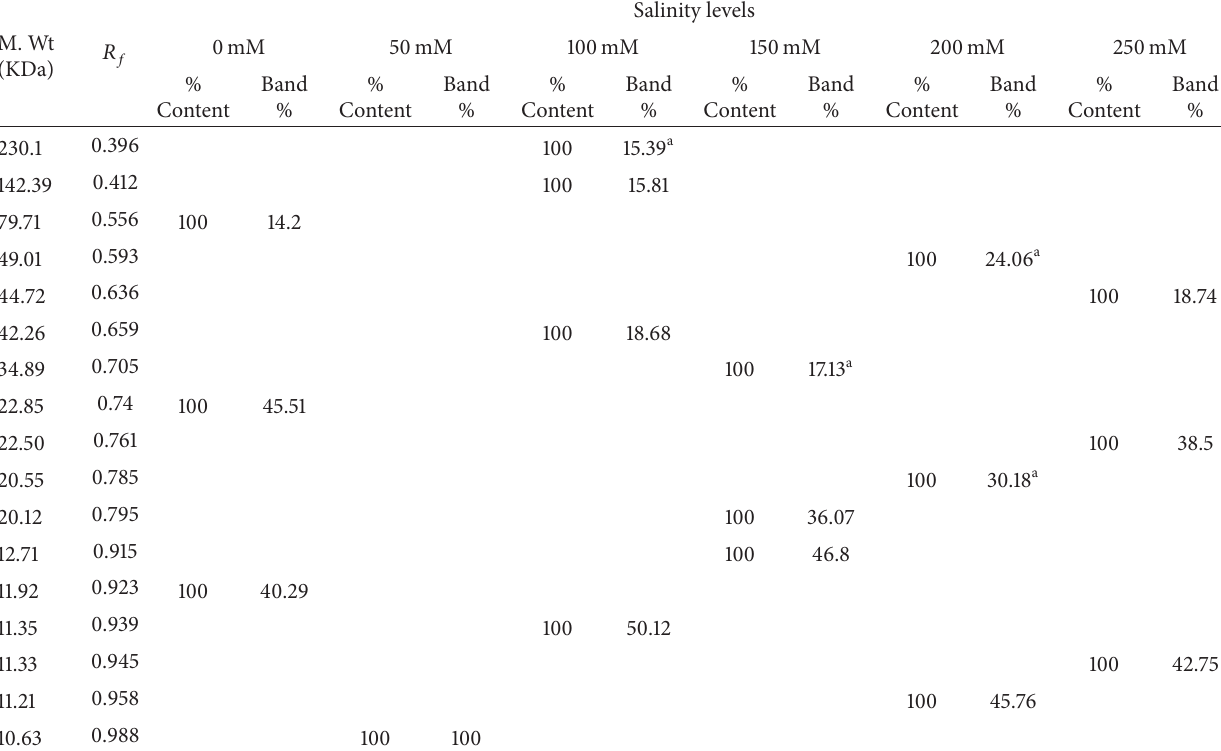
Table 1: Electrophoretic protein pattern of salinity stressed Triticum aestivum seedlings presoaked in distilled water.